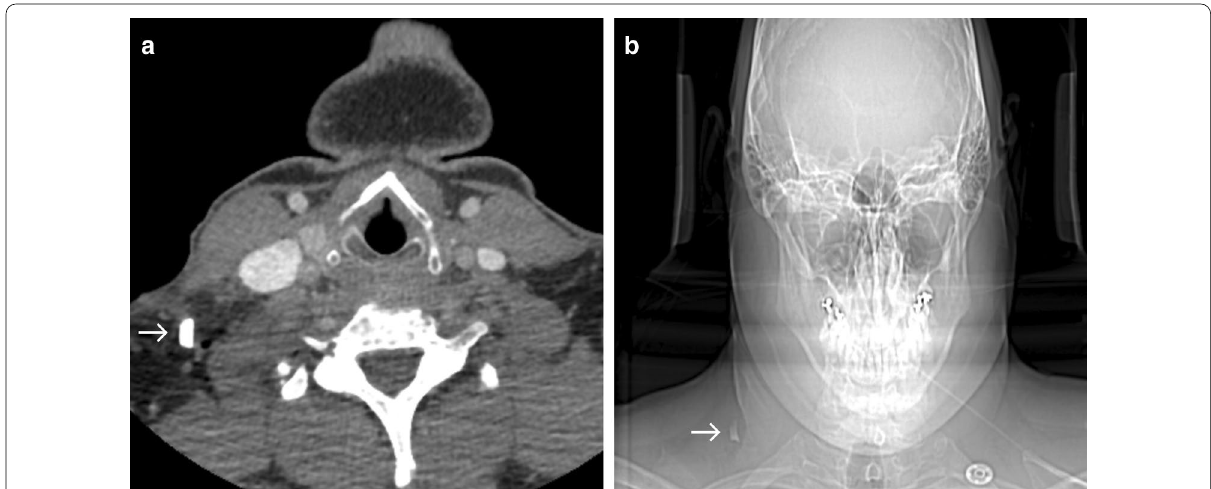
Fig. 10 Glass bottle fragment. Axial contrast enhanced CT image ( a ) and corresponding anteroposterior scout scan ( b ) displaying a hyperdense structure (arrow) in the right posterior cervical space dorsolateral to the sternocleidomastoid muscle. At first glance, this object could look like a metal fragment (compare Fig. 7b). Careful comparison, however, reveals a lack of streak artefacts in CT images which would be expected in metallic objects of this